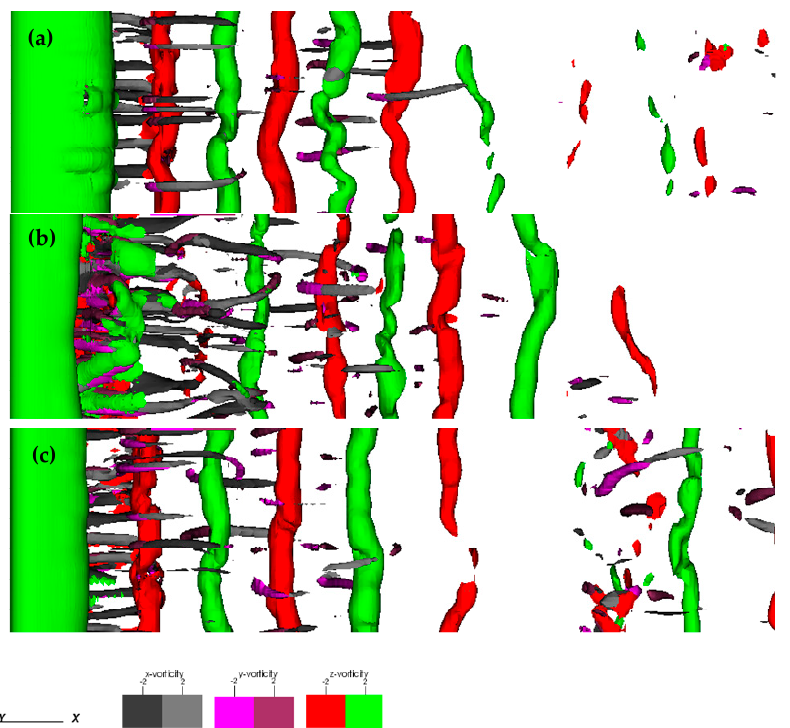
Figure 20. Counter-clockwise cylinder oscillation: Instantaneous vorticity isosurfaces (top view) for F = 0.8 and ( a ) A y /D = 0.10, ( b ), A y /D = 0.30, ( c ) A y /D = 0.40.